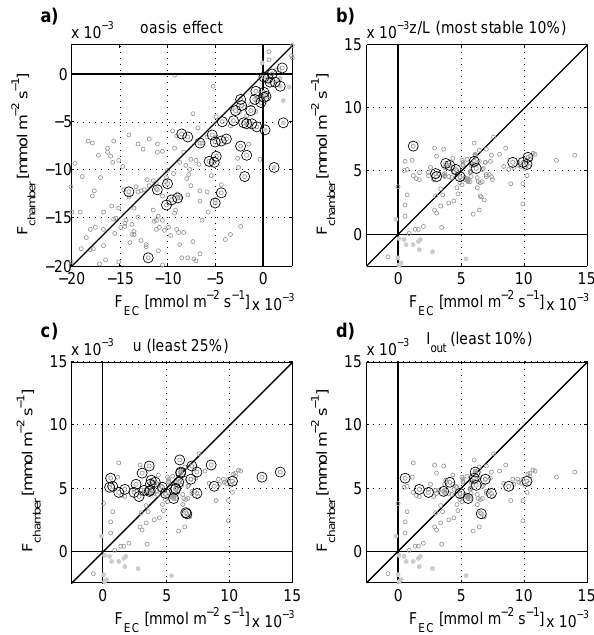
Fig. 3. Scatterplot sections of EC- and chamber-determined NEE under particular micrometeorological conditions: (a) oasis effect; (b) atmospheric stability z/L >0.7; (c) wind velocity u <0.9ms − 1 ; (d) outgoing long-wave radiation I out <319Wm − 2 – labeled with large black circles in each case; light grey circles represent fluxes with different directions.